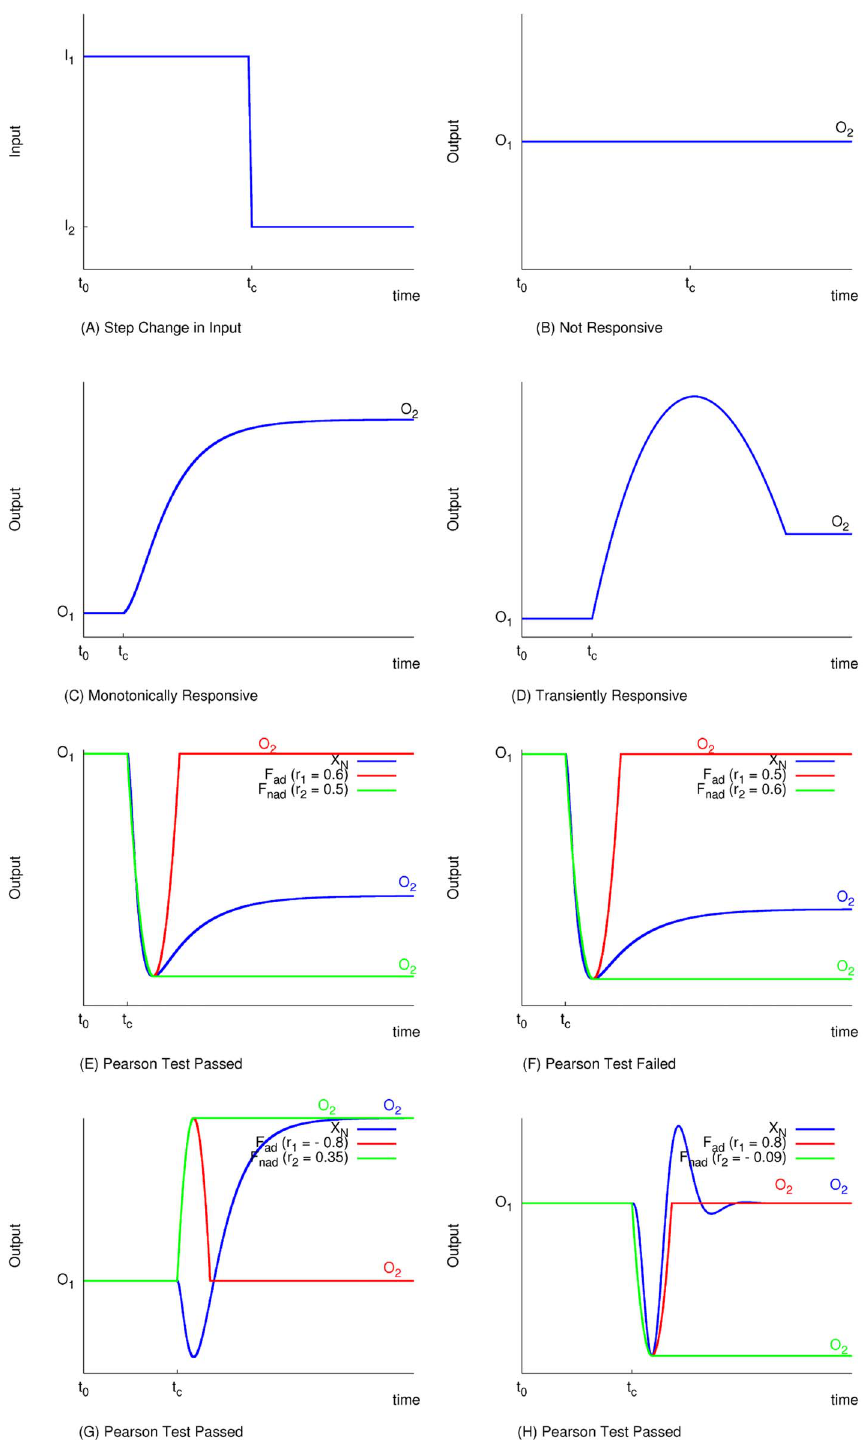
Figure 2. Illustrating the criterion for selecting for transiently responsive networks. The Pearson test is performed to decide whether a network (a particular choice of a set of parameters for a particular topology) shows a transient response to a step change in input or not. The starting point is at steady state under a constant input concentration I 1 . At time t c the input concentration is changed from I 1 to I 2 via a step function (A). Consequently the output will either (B) not sense the change and maintain the same steady state O 2 ~ O 1 , (C) change monotonically to a new steady state O 2 = O 1 , or (D) show a transient response followed by a relaxation to a new steady state O 2 that might or might not be equal to the pre-step change steady state O 1 . A network passes the test only if it is transiently responsive. (E–H) F ad (red) is a perfectly biochemically adaptable function and F nad (green) is a monotonically changing function. If The Pearson shape correlation between the computed time course (blue) and F ad , r 1 , is bigger than that between it and F nad , r 2 , then the test is passed (E, G, H) and the network is termed a Transiently- Responsive (TR) network, otherwise the test is failed (F) and the network is termed Non-Pearson (NP). In (E) and (F), we show two cases where a biased visual inspection would deem